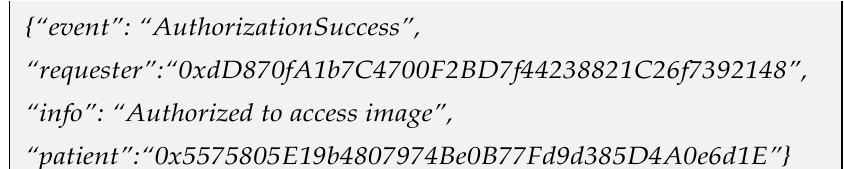
Figure 8. Case 3: event log stored in the blockchain. Information shows that the Figure 7. Case 2: event log stored in the blockchain for denying access to